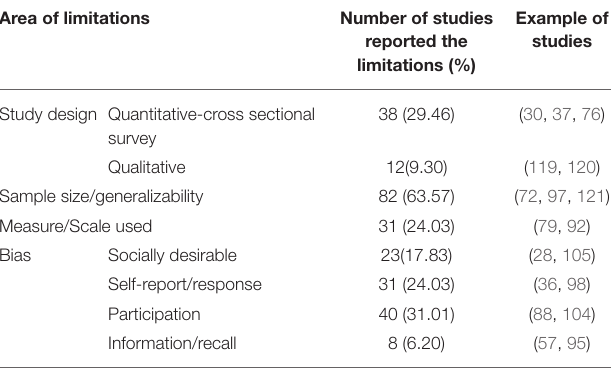
TABLE 2 | Limitations of MSM and transgender